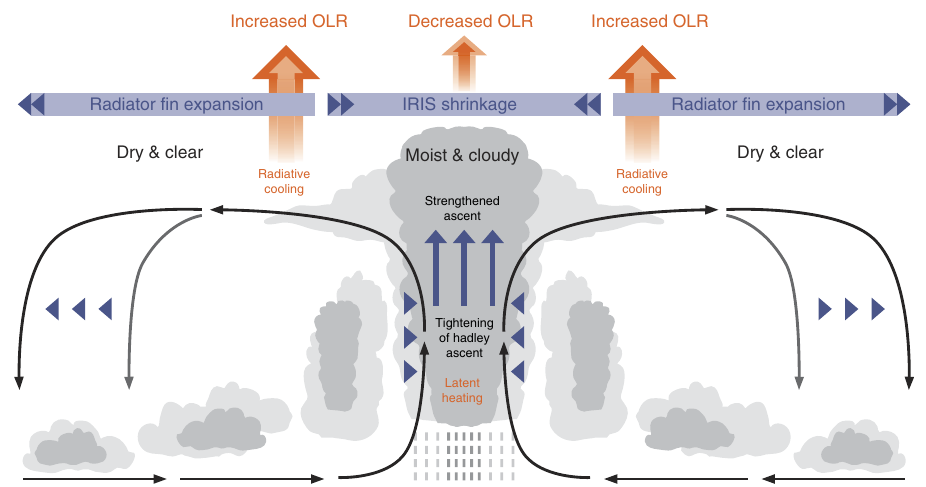
Figure 1 | A schematic of model simulated changes in the Hadley Circulation and tropical clouds along with the OLR and precipitation changes in a warmer climate. Black arrows mark the climatological Hadley Circulation with ascents near the equator and descents in the subtropics. Blue triangles indicate the poleward expansion of the descent zone and equatorward contraction of the ascending branch of the Hadley Circulation under global warming. The blue upward arrows indicate the strengthening of ascending motion over the equatorial tropics, where precipitation increases. The light and dark grey shadings of clouds correspond to the mean cloud distributions in the present and future climate, respectively, highlighting the rise of cloud top and the decrease of high cloud cover over the equatorial tropics and the reduction of low cloud amount in the subtropics. The higher cloud top causes decreased OLR over the equator, while the decrease of high cloud cover leads to increased OLR away from the equator. The schematic is based on multimodel-mean climate model simulations in response to increasing CO 2 (refs